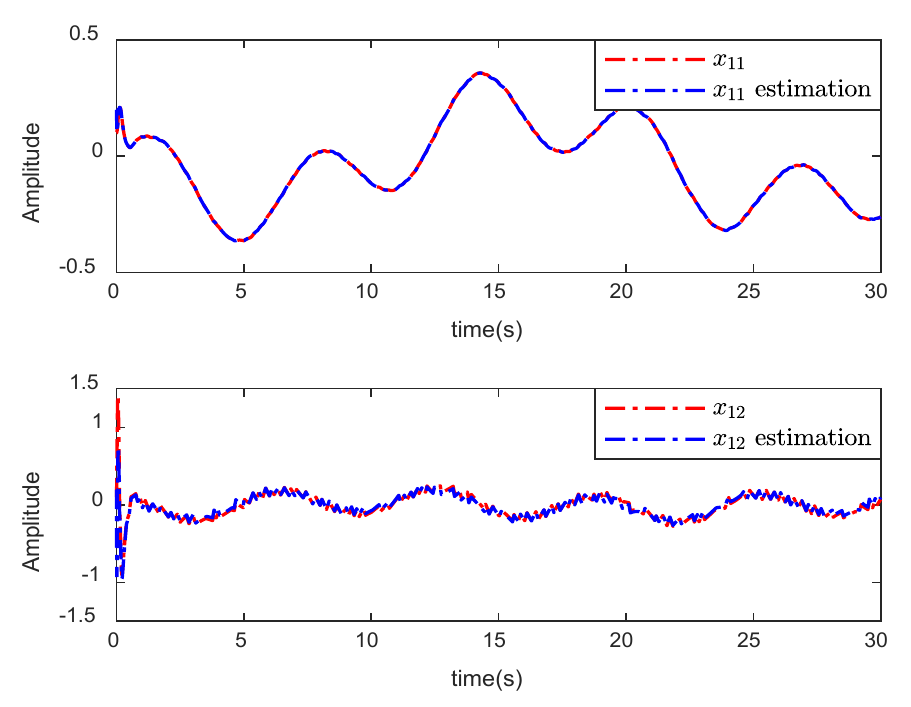
Figure 7. The trajectories of the x 1,1 , x 1,1 estimation and x 1,2 , x 1,2 estimation.